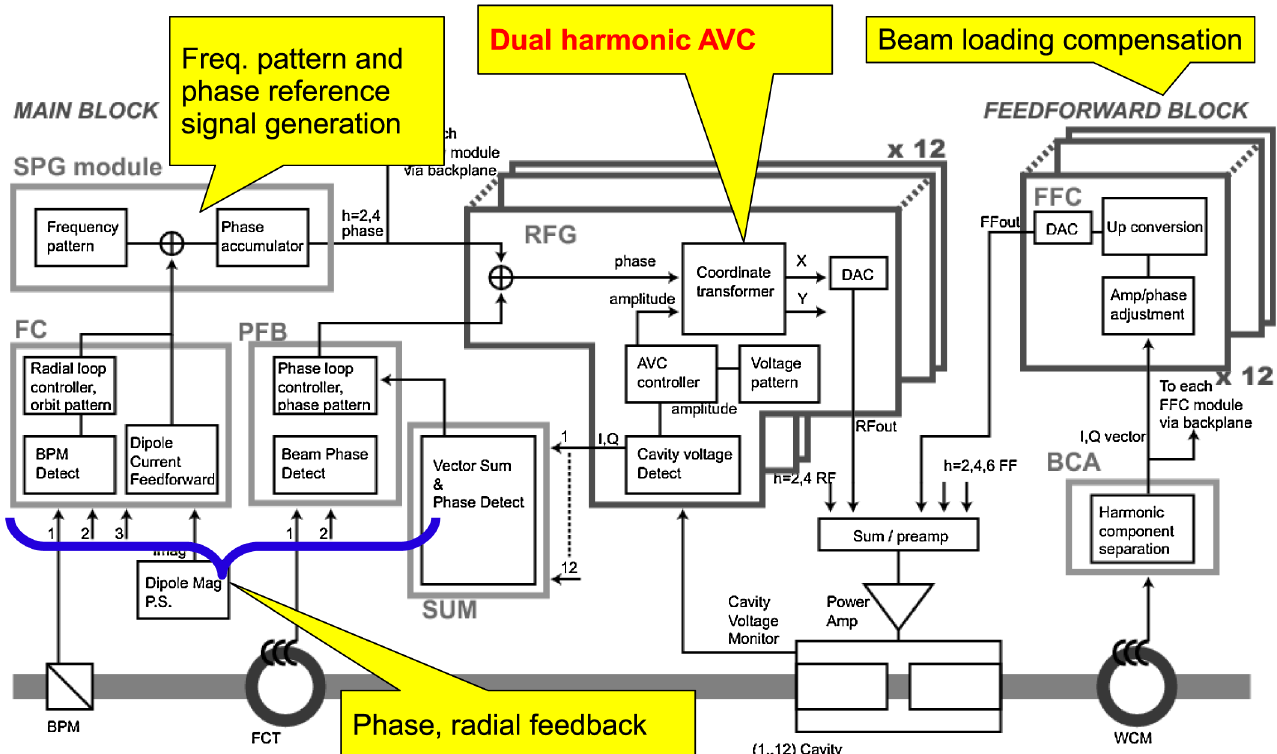
FIG. 1. Simplified block diagram of the RCS LLRF control